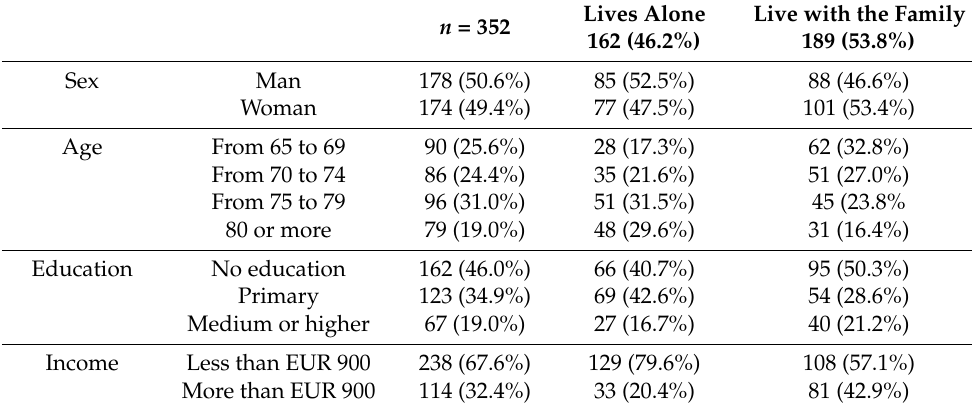
Table 1. Sociodemographic characteristics of the